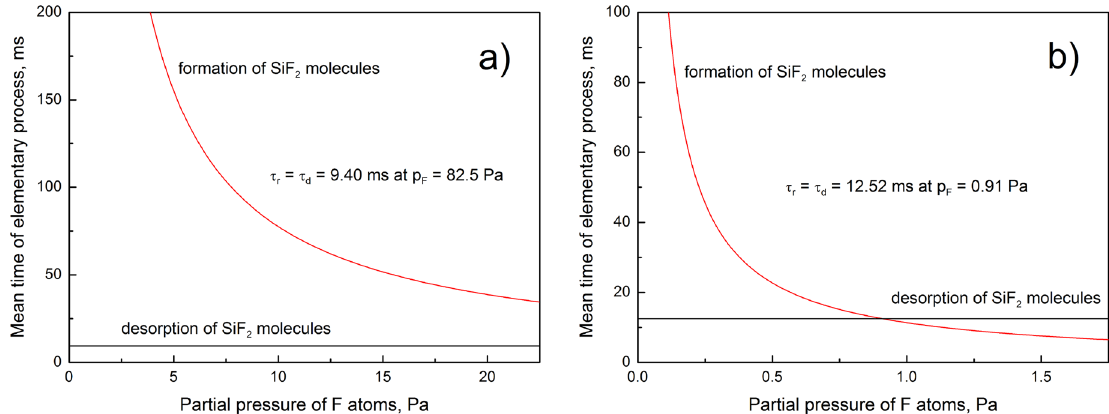
Figure 3. The theoretical dependences of mean times of elementary processes on the partial pressure of F atoms: ( a ) experiment 17 , ( b ) experiment 18 .